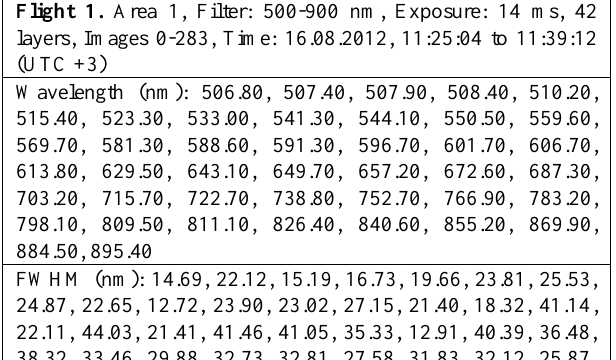
Flight 2. Area 1, Filter: 600-750 nm, Exposure: 20 ms, 29